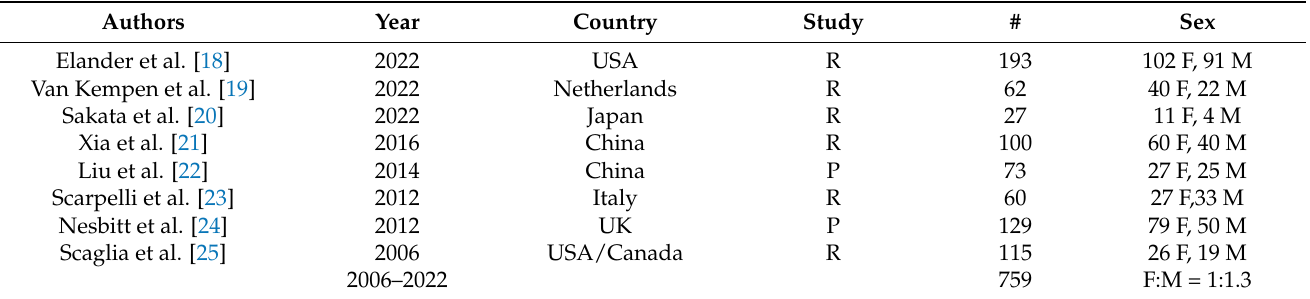
Table 1. Study demographics (R: retrospective, P: prospective, M: male, F: female, and # = number of patients).